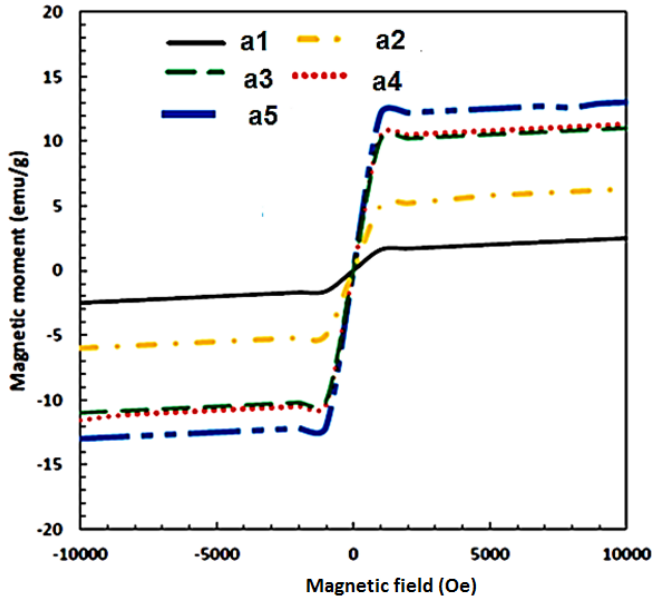
Figure 14. Magnetic hysteresis curve for Al-Fe 3 O 4 with different weight percentages at ambient temperature.